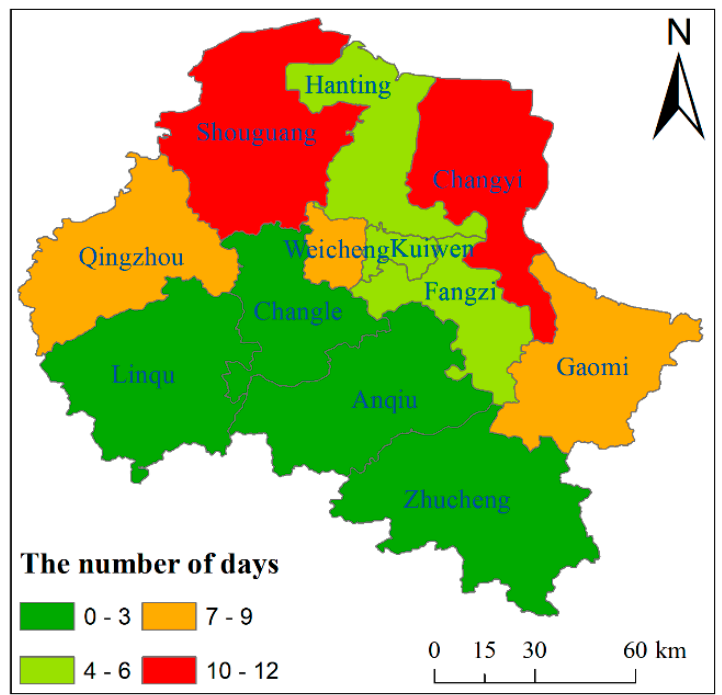
Figure 5. The days of daily average concentration of SO 2 exceeding 20 μ g/m³ in winter of 2020 in Weifang.